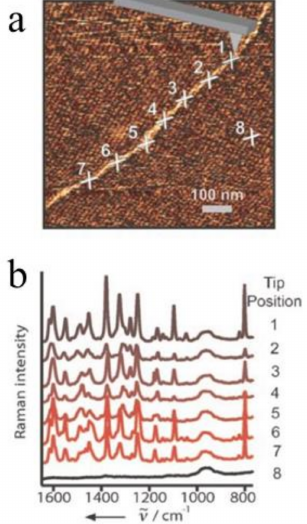
Figure 4. TERS experiment along an RNA strand. ( a ) Topography image (same as in Figure 2a) showing seven adjacent spots corresponding to the positions of the TERS experiments and one additional spot for the reference measurement (position 8); ( b ) The Ramans pectra of positions in ( a ). Reprinted with permission from ref. [44]. Copyright 2008, Wiley-VCH Verlag GmbH & Co. KGaA, Weinheim,